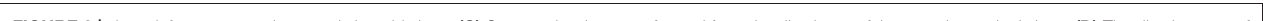
FIGURE 2 | sinus, left transverse sinus, and sigmoid sinus. (C) Stent retrieval was performed from the distal part of the superior sagittal sinus. (D) The distal aspect of the superior sagittal sinus appears better than the anterior. (E) The intermediate catheter is delivered to the superior sagittal sinus midshaft using stent anchoring. (F) Thrombus retrieval in the middle segment of the superior sagittal sinus was performed using the solumbra technique. (G) The middle section of the superior sagittal sinus is better developed than before, but there is still proximal stenosis. (H) Stent retriever was performed to the proximal end of the superior sagittal sinus. (I) The posterior of the superior sagittal sinus appears better than the anterior. (J) Intravenous retrograde contrast suggests improved visualization of the superior sagittal, bilateral transverse, and sigmoid sinuses. (K) Intraoperative retrieved thrombus. (L) Review of DSA 90 days postoperatively suggests good visualization of the superior sagittal sinus.